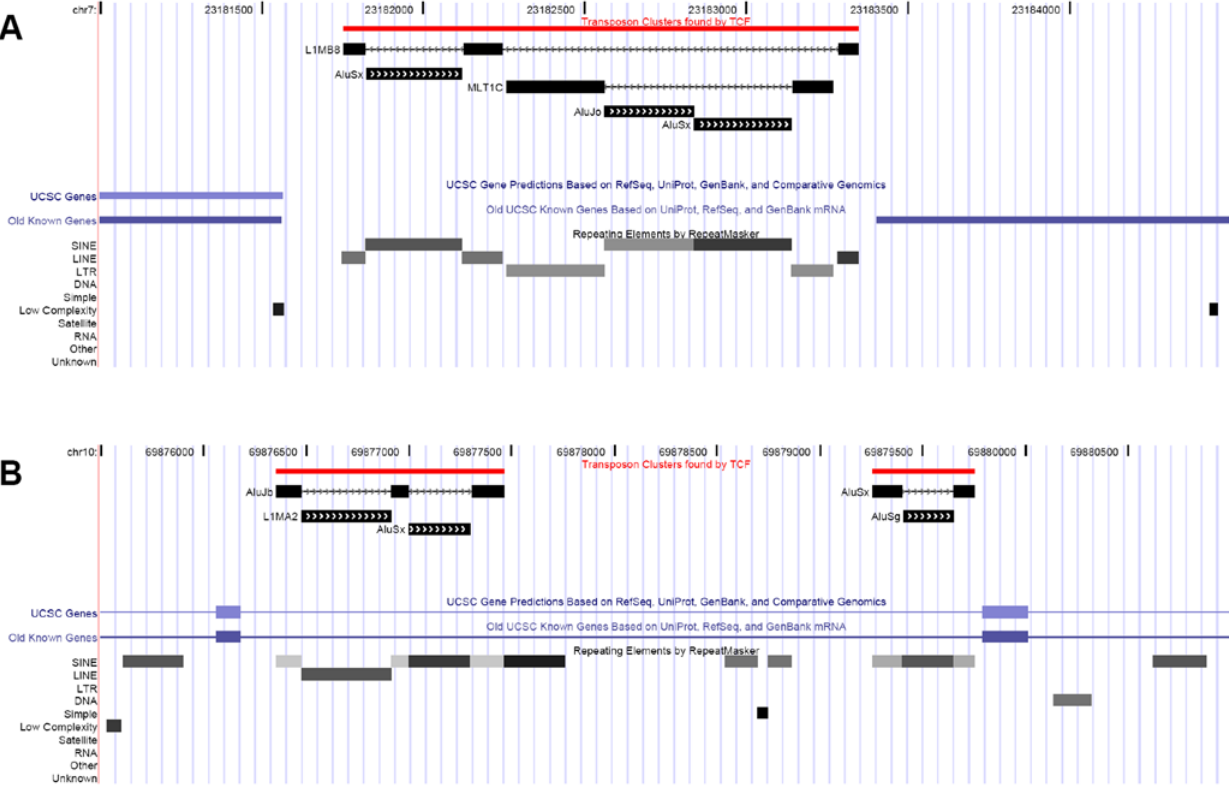
Figure 1. Examples of transposon clusters. A) An ancient L1MB8 element was interrupted by an Alu and a LTR repeat, which in turn was further interrupted by two Alus. B) Alu repeats interrupted by an L1 and other Alus. The UCSC custom track that visualizes TE clusters is downloadable from. http://www.mssm.edu/labs/warbup01/paper/files.html.